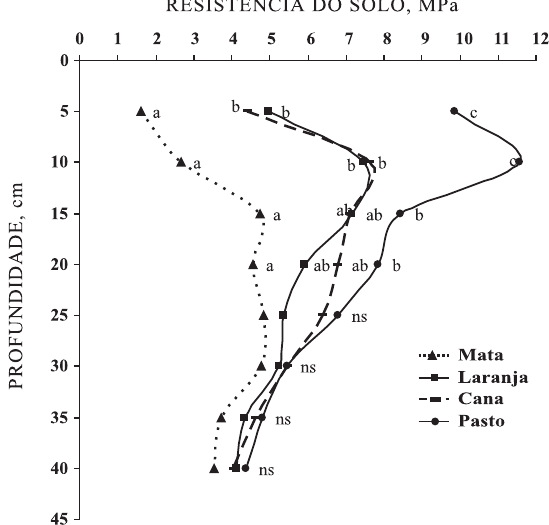
Figura 2. Resistência do solo à penetração em Latossolo sob mata, laranja, cana e pastagem, com umidade do solo de 0,165; 0,153; 0,199; e 0,135 kg kg -1 , respectivamente. Médias seguidas pela mesma letra, em cada profundidade, não diferem estatisticamente entre si pelo teste de Tukey a 5 %.